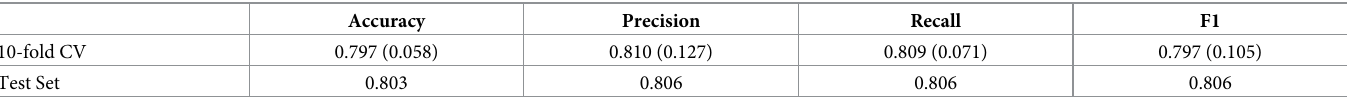
Table 3. Results for the fine-tuned GPT-3 Babbage model obtained by the 10-fold CV where the mean (standard deviation) are reported, and evaluated on test set for AD